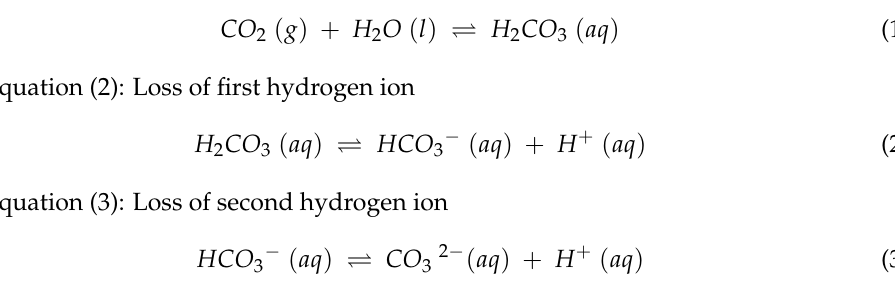
Figure 12. pH Variation.